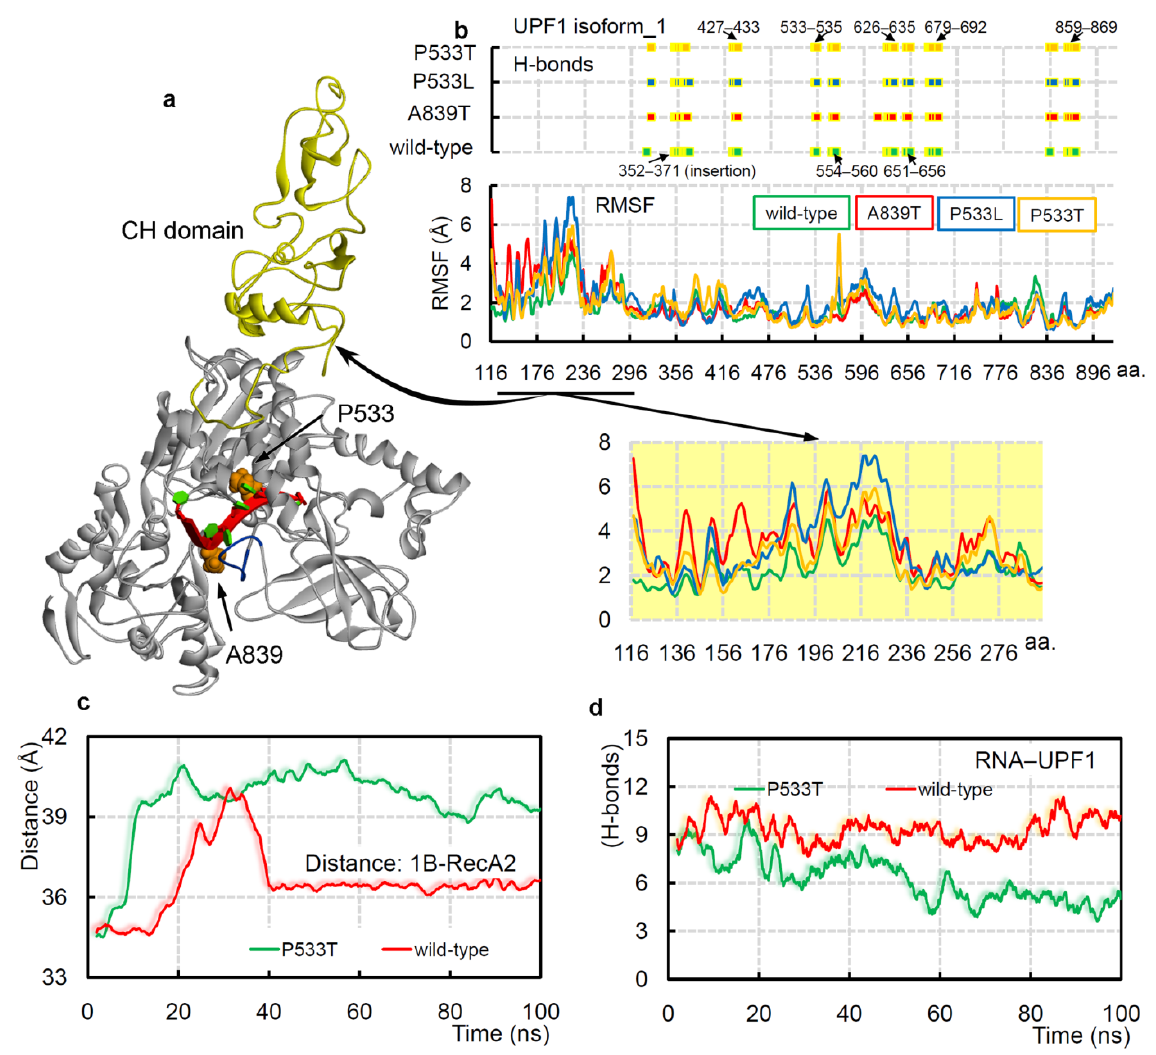
Figure 5. The cancer variants UPF1 A839T and UPF1 P533L/T can influence the protein–mRNA binding dynamics. ( a ) UPF1 iso ‐ form_1 structure representing mutated residues in its RNA-binding pocket, and the CH domain is colored in yellow. The 11 aa insertion (353-GNEDLVIIWLR-363) for UPF1 isoform_1 is also highlighted in blue. ( b ) The protein–poly(U) mRNA intermolecular hydrogen bond interactions in wild-type and different mutated systems. Amino acids from the following range of the UPF1 isoform_1 protein were involved in poly(U) mRNA binding: S352–D371, K427–R433, P533–N535, R554–R560, C626–R635, Q651–E656, P679–S692, S836–Q841, and Q859–R869. The bottom panel represents RMSFs (root- mean-square fluctuations) of individual amino acids of UPF1 (isoform_1) under different conditions. The regions formed by the CH-domain showing high RMSF fluctuations are highlighted. ( c ) The distance center of mass between 1B and RecA2 domains of UPF1 isoform_1 with poly(U) mRNA in the UPF1 P533T mutated and wild-type systems. ( d ) The UPF1–poly(U) mRNA intermolecular interactions from the UPF1 P533T and wild ‐ type systems.